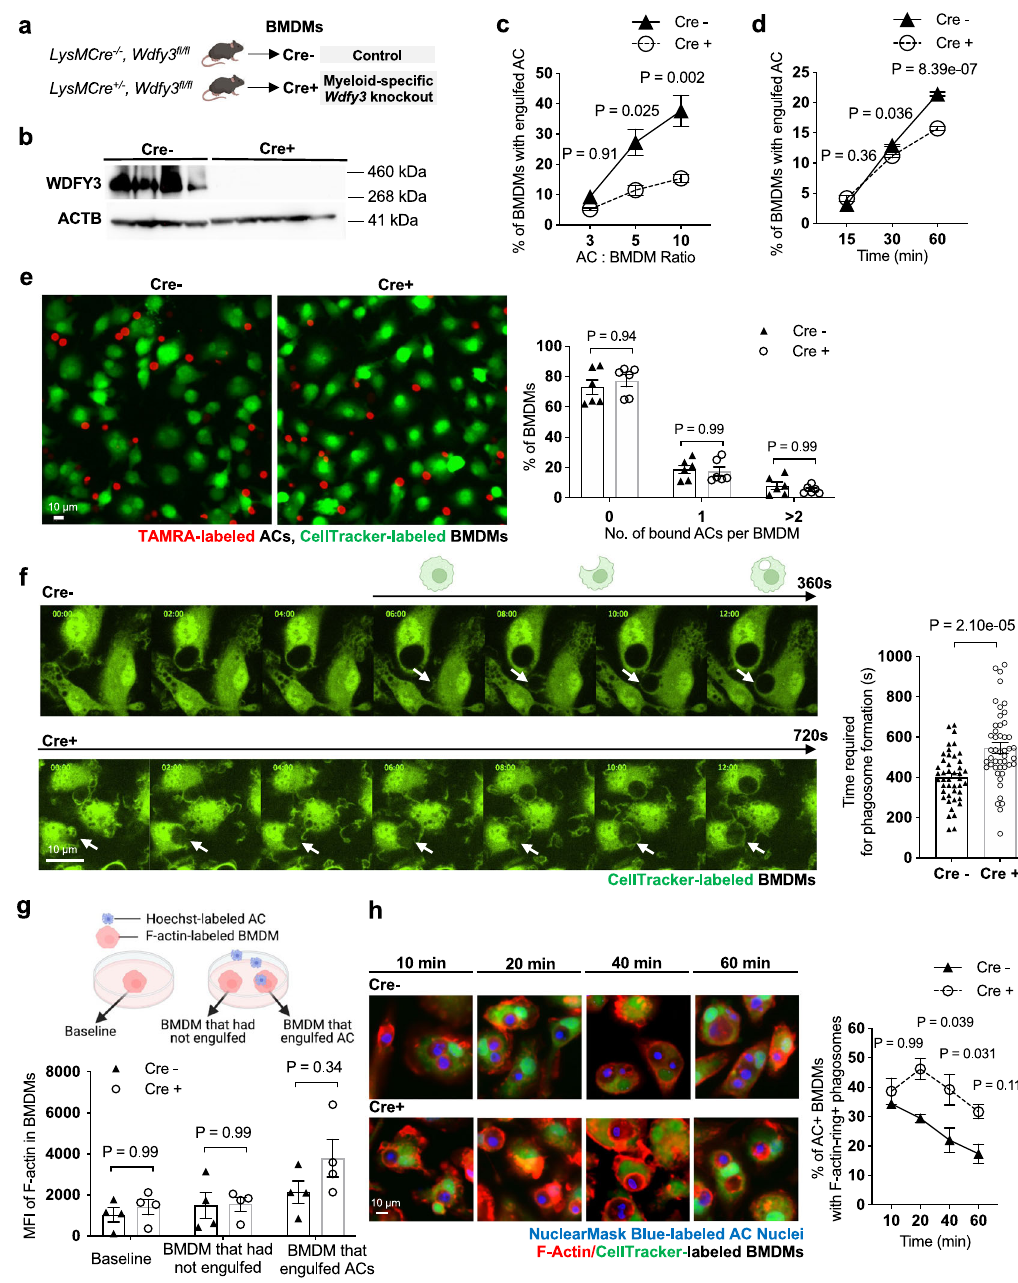
Fig. 2 | WDFY3 de fi ciency led to impaired uptake, as opposed to binding, of apoptotic cells (ACs) due to defective actin depolymerization. a Schematics of breeding LysMCre mice with Wdfy3 fl / fl mice to obtain mice with myeloid-speci fi c knockoutof Wdfy3 . b Validationofef fi cientknockoutinBMDMsbywesternblotof WDFY3 ( n =4 biological replicates; the blot shown is a representative image of three independent experiments). c Cre - and Cre + BMDMs were incubated with Hoechst-labeledACsatvarious AC:BMDMratiosof3:1, 5:1, 10:1 respectivelyfor 1h and analyzed by fl ow cytometry ( n =3 biological replicates, each from the average of 2 technical replicates). d Cre - and Cre + BMDMs were incubated with PKH26- labeled ACs at various time points of 15min, 30min, and 60min at a AC: BMDM ratio of 5:1 and analyzed by fl ow cytometry ( n =3 technical replicates). e Cre - and Cre + BMDMs were pretreated with cytochalasin D for 30min to block poly- merization and elongation of actin, thus testing the binding of ACs with BMDMs. The treated BMDMs were then incubated with TAMRA-stained apoptotic mouse thymocytes at 37°C for 30min and then extensively washed with DPBS to remove unbound ACs for imaging and quanti fi cation after fi xation ( n =6 biological repli- cates). f Cre - and Cre + BMDMs were stained with CellTracker and incubated with